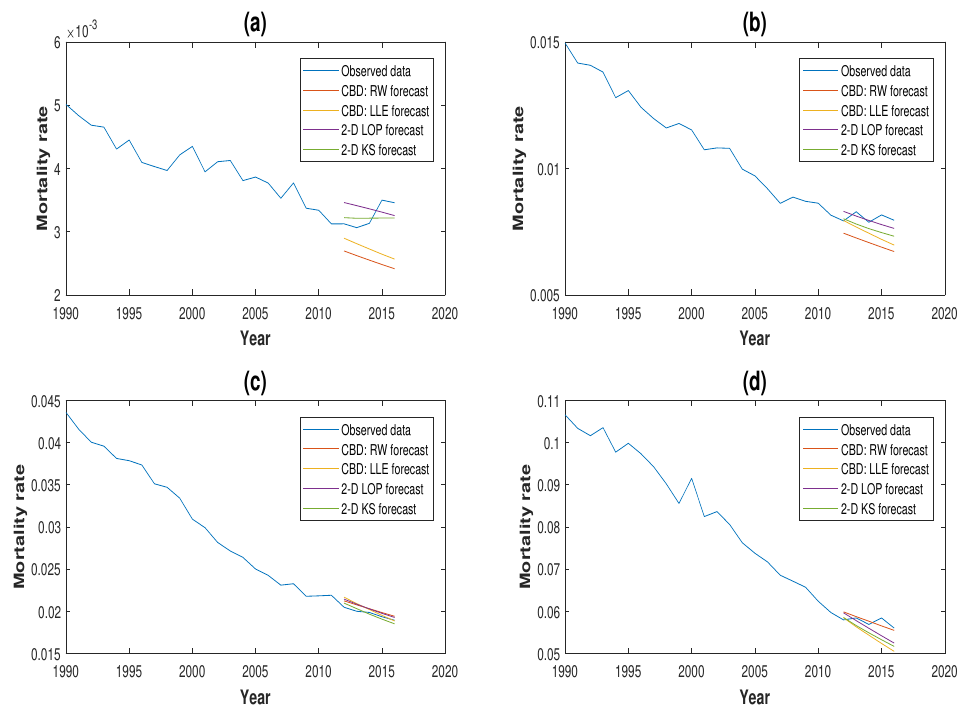
Figure 6. Five-year-ahead forecast from 2012–2016 for GB males aged ( a ) 50, ( b ) 60, ( c ) 70 and ( d ) 80 based on mortality data since 1970.